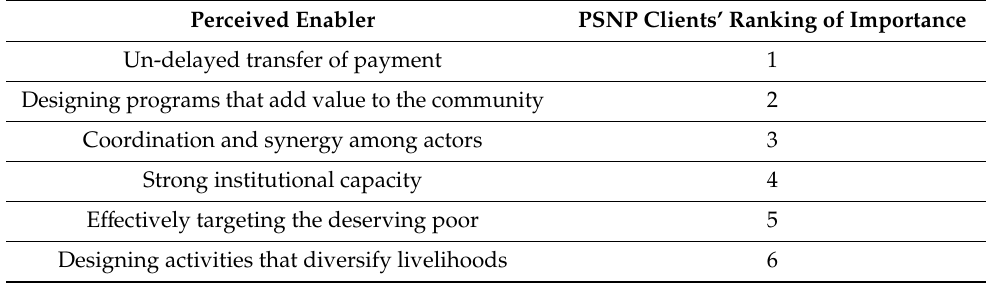
Table 2. Respondents’ Ranking of “Enablers” of Social Protection Service